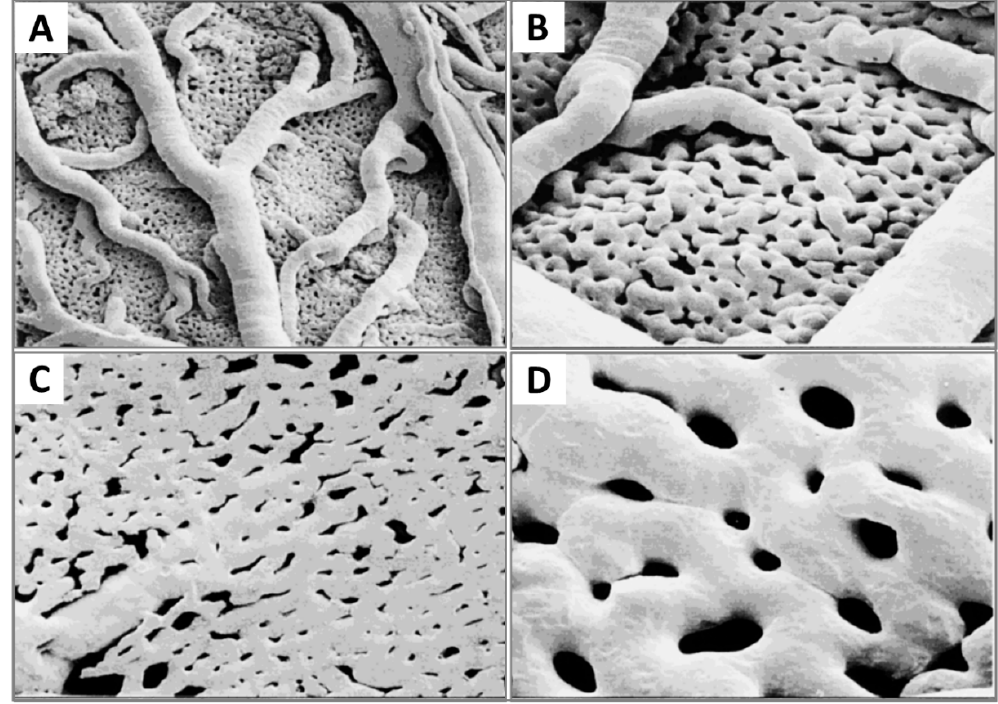
Figure 7. Resin corrosion cast (Mercox cast) of the developing CAM vasculature at ED 12. ( A , B ) A three-dimensional structure containing a capillary plexus and a layer of supplying and collecting vessels is recognisable. ( C , D ) Numerous pillars of different sizes caused by intussusceptive angiogenesis processes. Original magnification: ( A ) 3100, ( B , C ) 3200 and ( D ) 3400. Reproduced with permission from